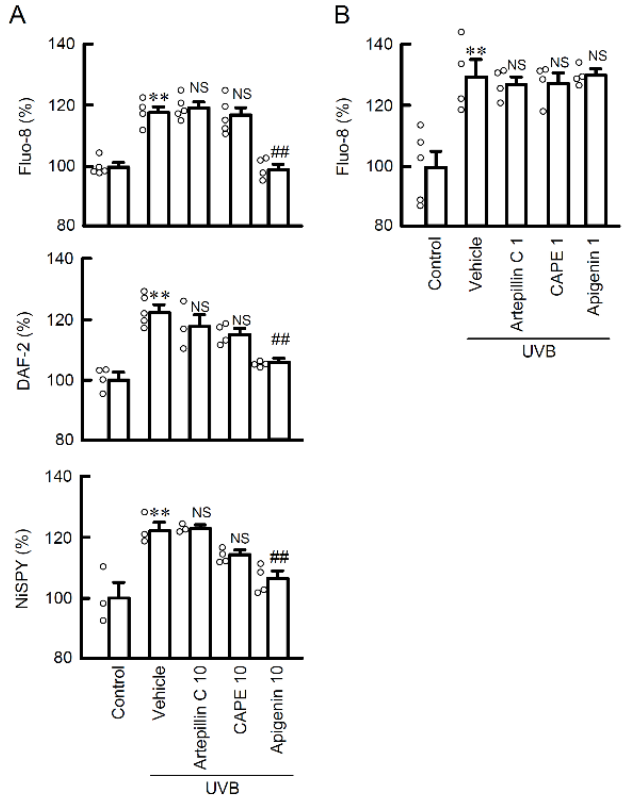
Figure 4. Effects of propolis components on Ca 2+ influx and RNS generations in the weak UVB exposed cells. ( A ) The cells were incubated in the absence (vehicle) and presence of 10 µ M artepillin C, 10 µ M CAPE, and 10 µ M apigenin for 30 min, followed by exposure to 5 mJ/cm 2 UVB for 6 h. After 3 h, the cells were incubated with 5 µ M Fluo-8 AM, 5 µ M DAF-2DA, or 5 µ M NiSPY-3 for 30 min. The fluorescence intensities of Fluo-8, DAF-2, and NiSPY-3 were measured by a microplate reader. ( B ) The cells were incubated in the absence (vehicle) and presence of 1 µ M artepillin C, 1 µ M CAPE, and 1 µ M apigenin. The data were presented as a percentage of control. n = 3–5. ** p < 0.01 vs. control. ## p < 0.01 and NS p > 0.05 vs. vehicle.